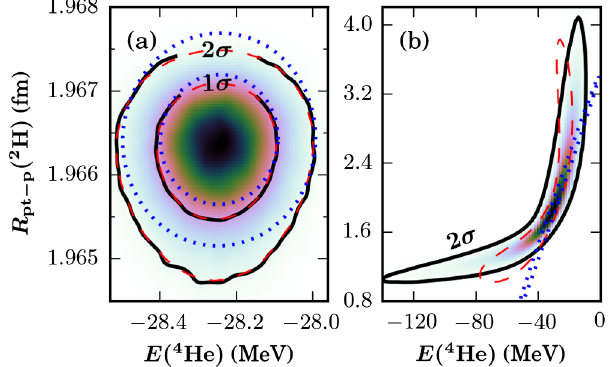
FIG. 8. Joint statistical probability distribution for E ð 4 He Þ and 2 H Þ for (a) NNLOsim and (b) NNLOsep obtained in a r pt-p ð 10 5 ) as described in the text. Monte Carlo sampling ( N sample ¼ Contour lines for this distribution are shown as black solid lines, while blue dotted (red dashed) contours are obtained assuming a linear (quadratic) dependence on the LECs for the